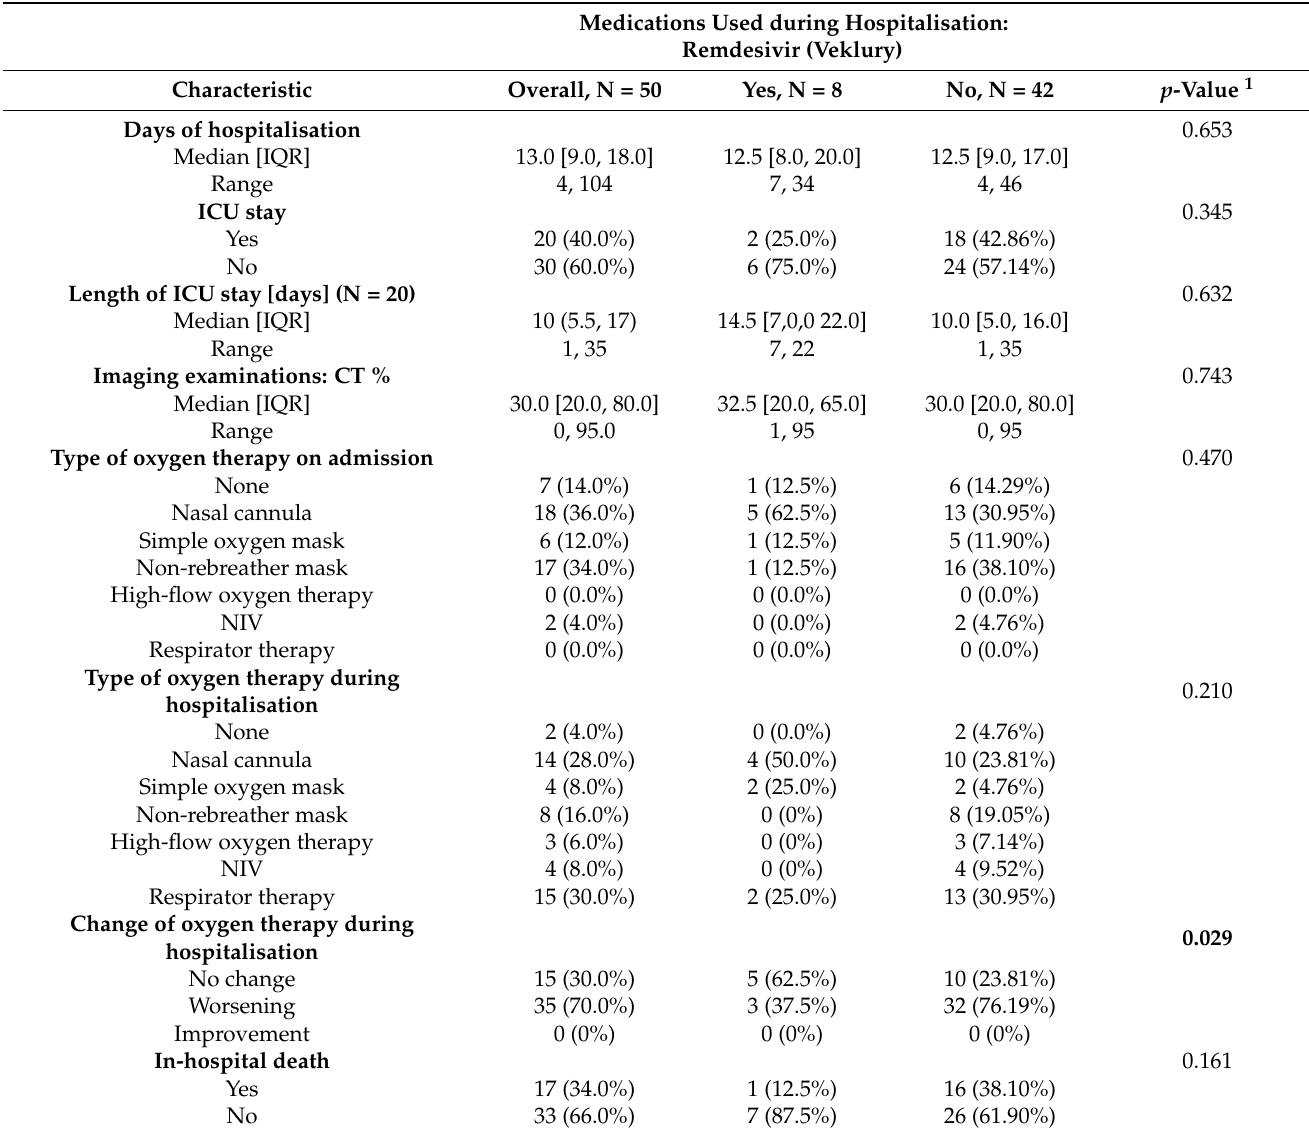
Table 10. Severity of COVID-19 vs. remdesivir medication, comparison between groups. Medications Used during